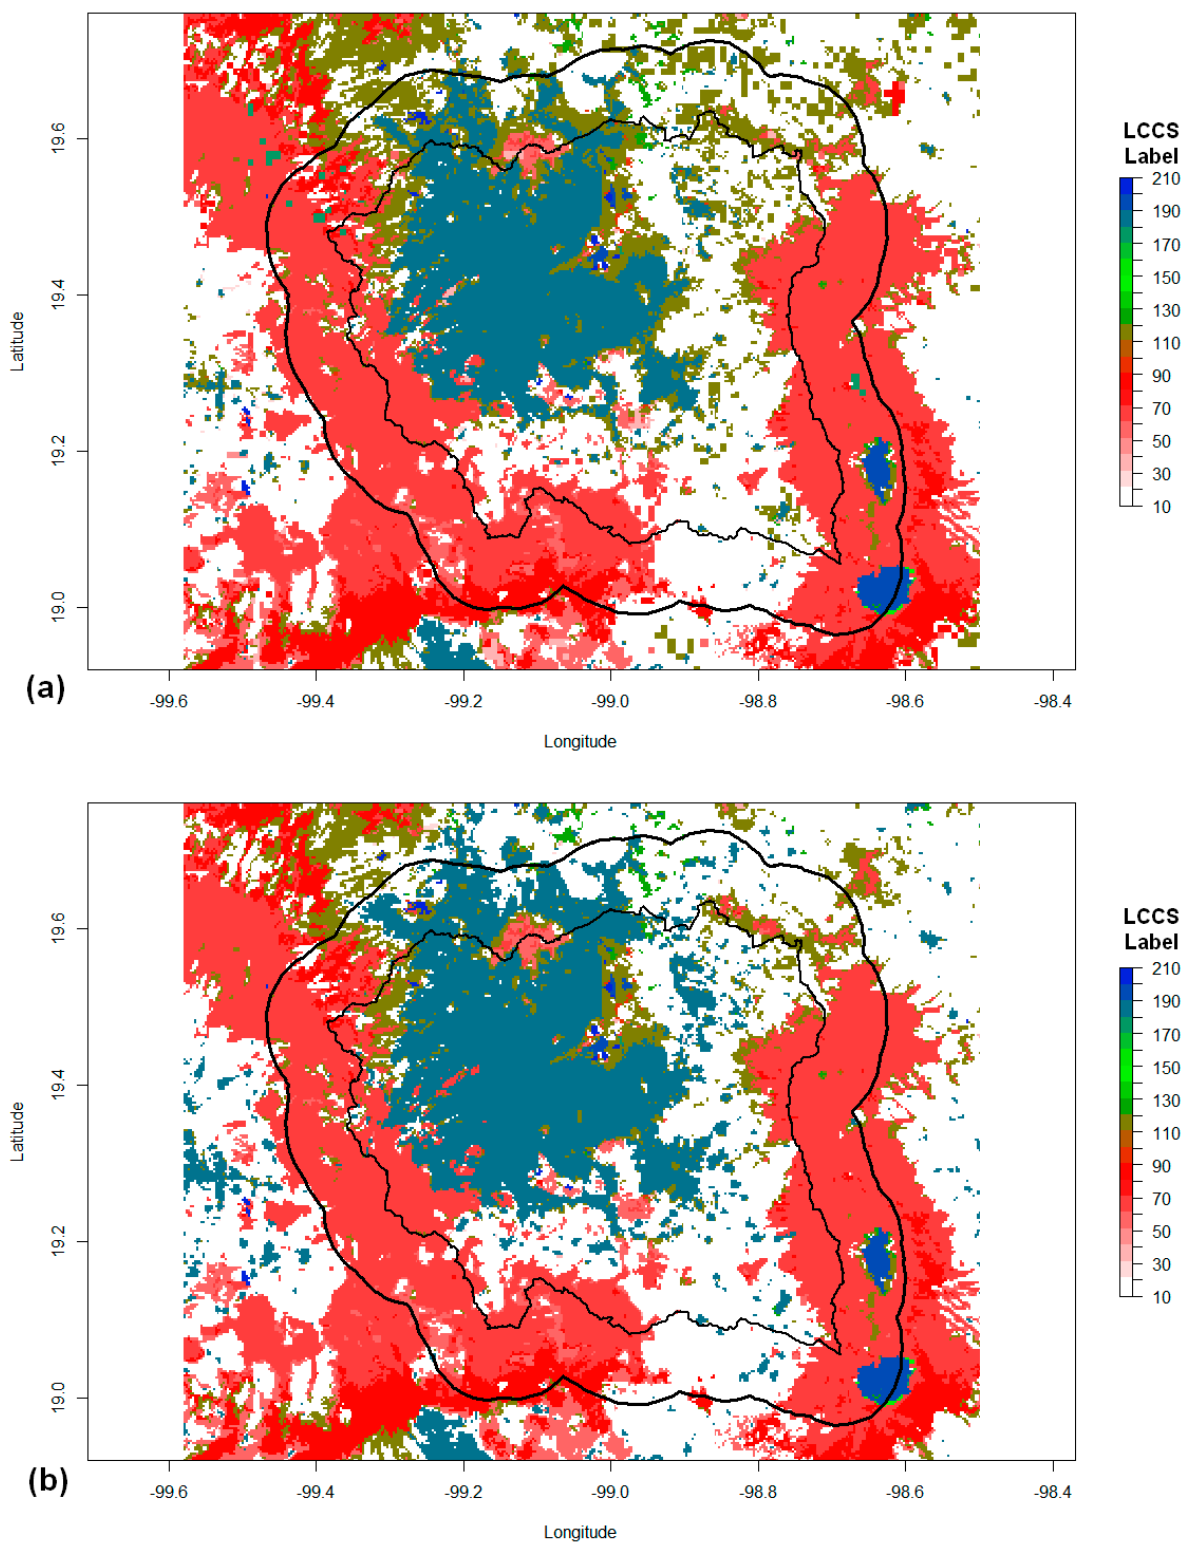
Figure 3. Maps of land cover for ( a ) the year 1992 and ( b ) the year 2010, according to the Land Cover Climate Change (LC–CCI) of the European Space Agency classification in the VMB [47]. Legend according to the Land Cover Classification System (LCCS) labels (Table 2). Label 190 is for urban areas.